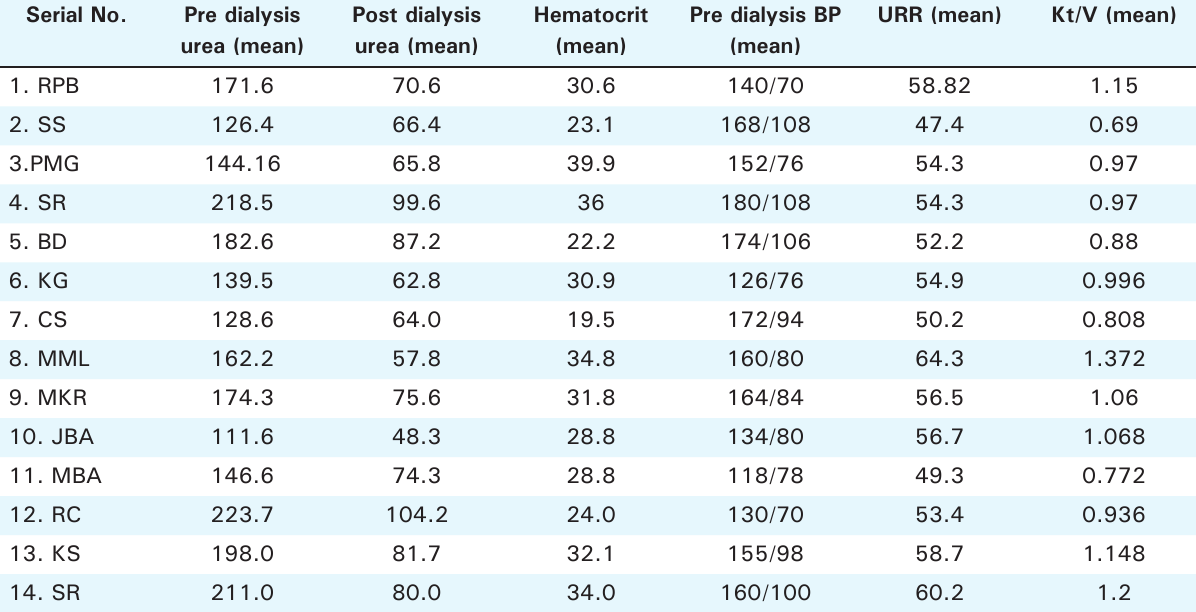
table 1. characteristics of patients included in the study serial